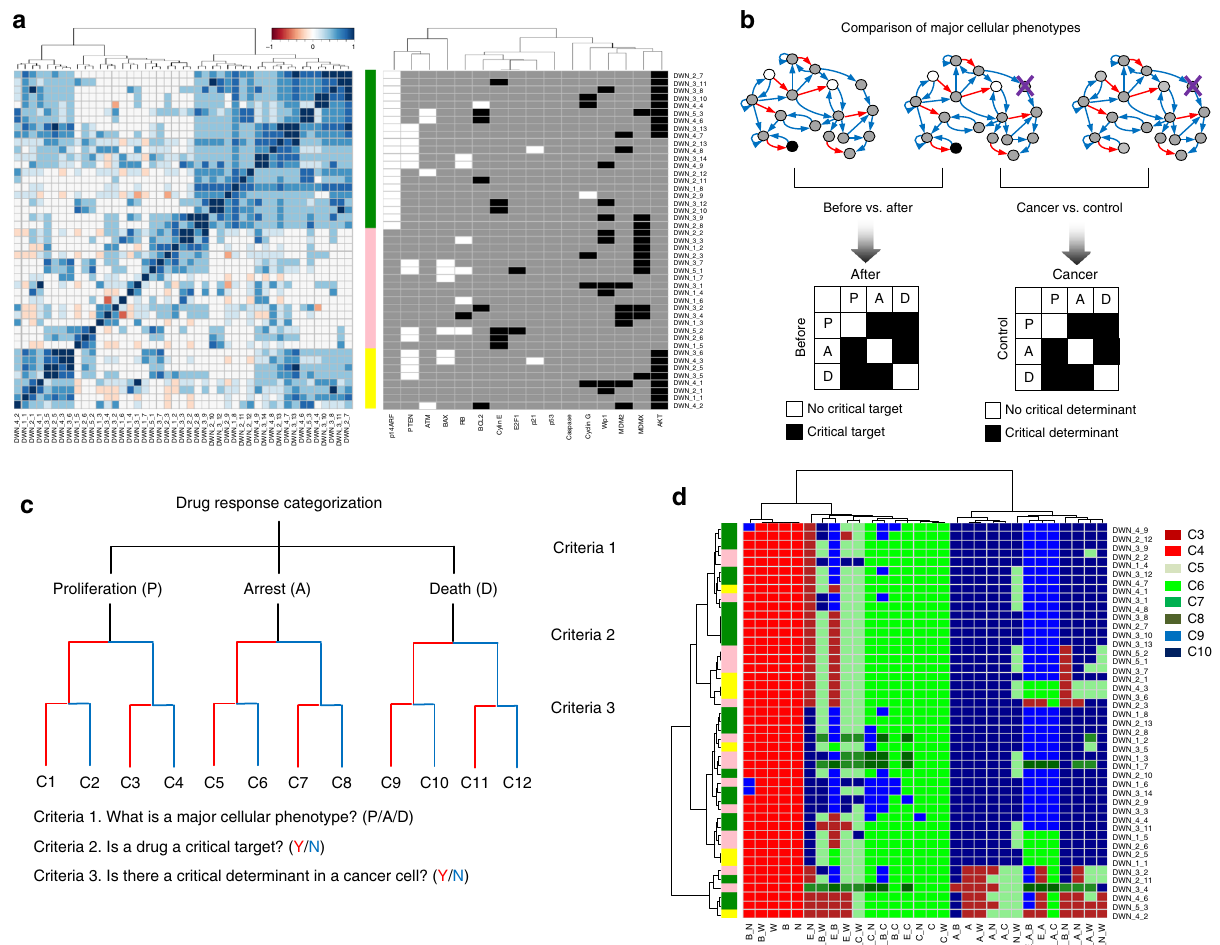
Fig. 3 Classi fi cation of cellular response to single and combinatorial perturbations. a Network similarity-based clustering of 45 differentially wired networks. They were divided into three subgroups (subgroup 1: green, subgroup 2: pink, subgroup 3: yellow). b A major cellular response phenotype of cancer network after drug treatment is compared with that before drug treatment to identify the presence or absence of “ critical target ” . Also, it is compared with a major cellular phenotype of control (normal) network to identify the presence or absence of “ critical determinant ” . c , d Based on results of the attractor landscape analysis, heterogeneous drug responses of the 45 p53 network subtypes from the 83 human cancer cell lines were classi fi ed into eight distinct response groups by three criteria, including the major drug response phenotype (P/A/D), the presence or absence of critical target, and the presence or absence of the set of critical genomic